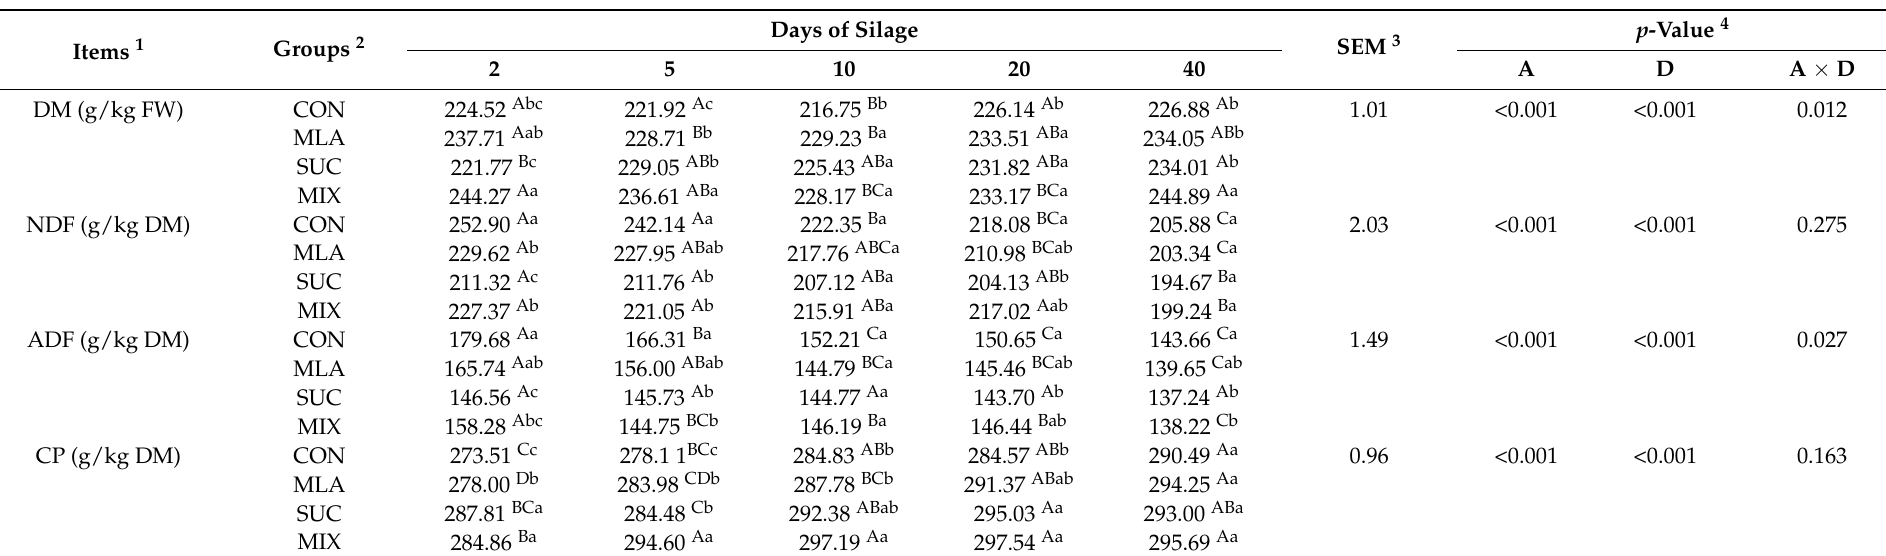
Table 2. Chemical composition of ensiled Moringa oleifera leaves treated with malic acid and